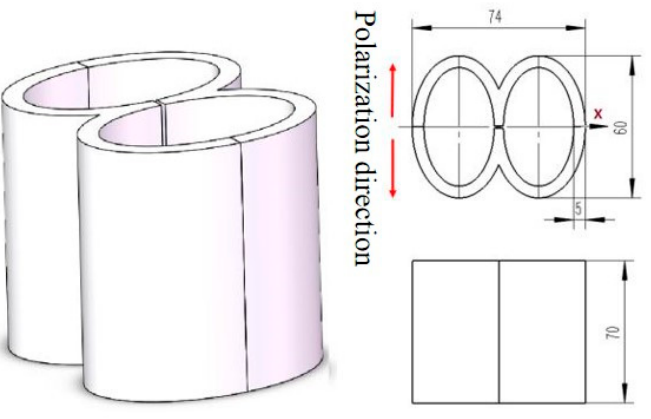
Figure 29. Low frequency transducer with two piezoelectric ceramic elliptical shells.